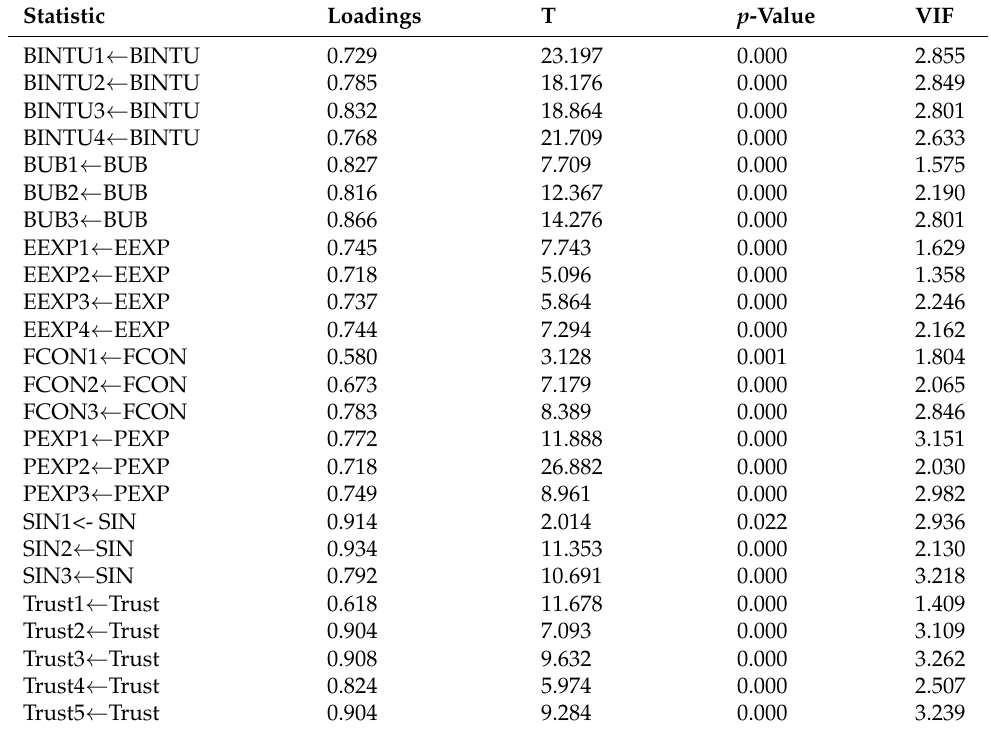
Table 7. Non-collinearity variance inflation factor (VIF) test.